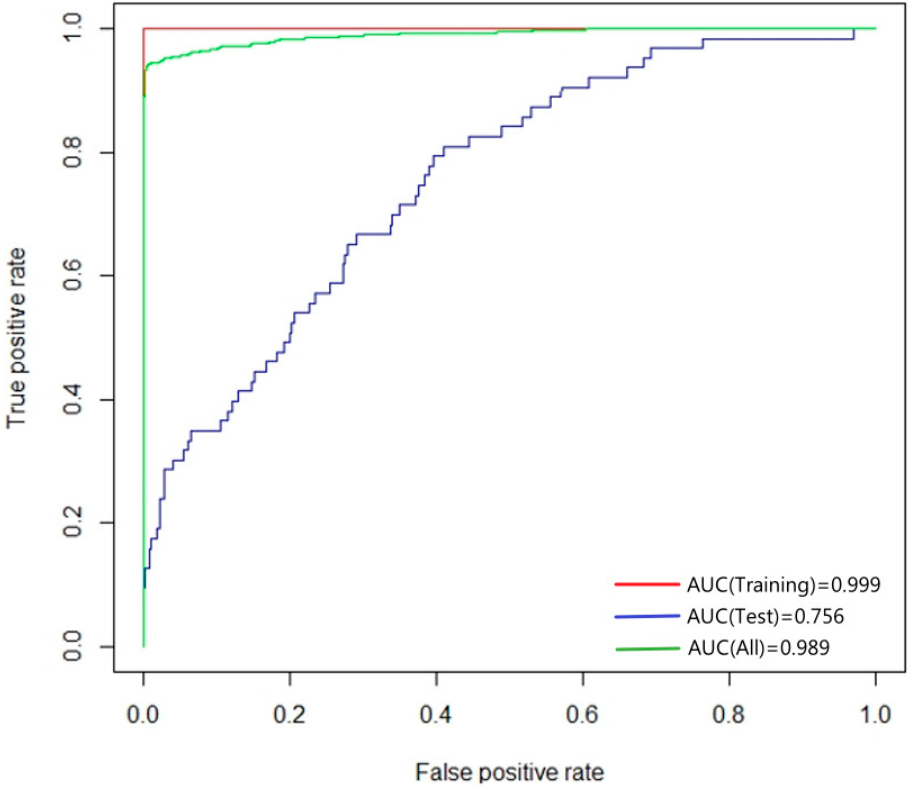
Figure 4. ROC curves and AUC values.